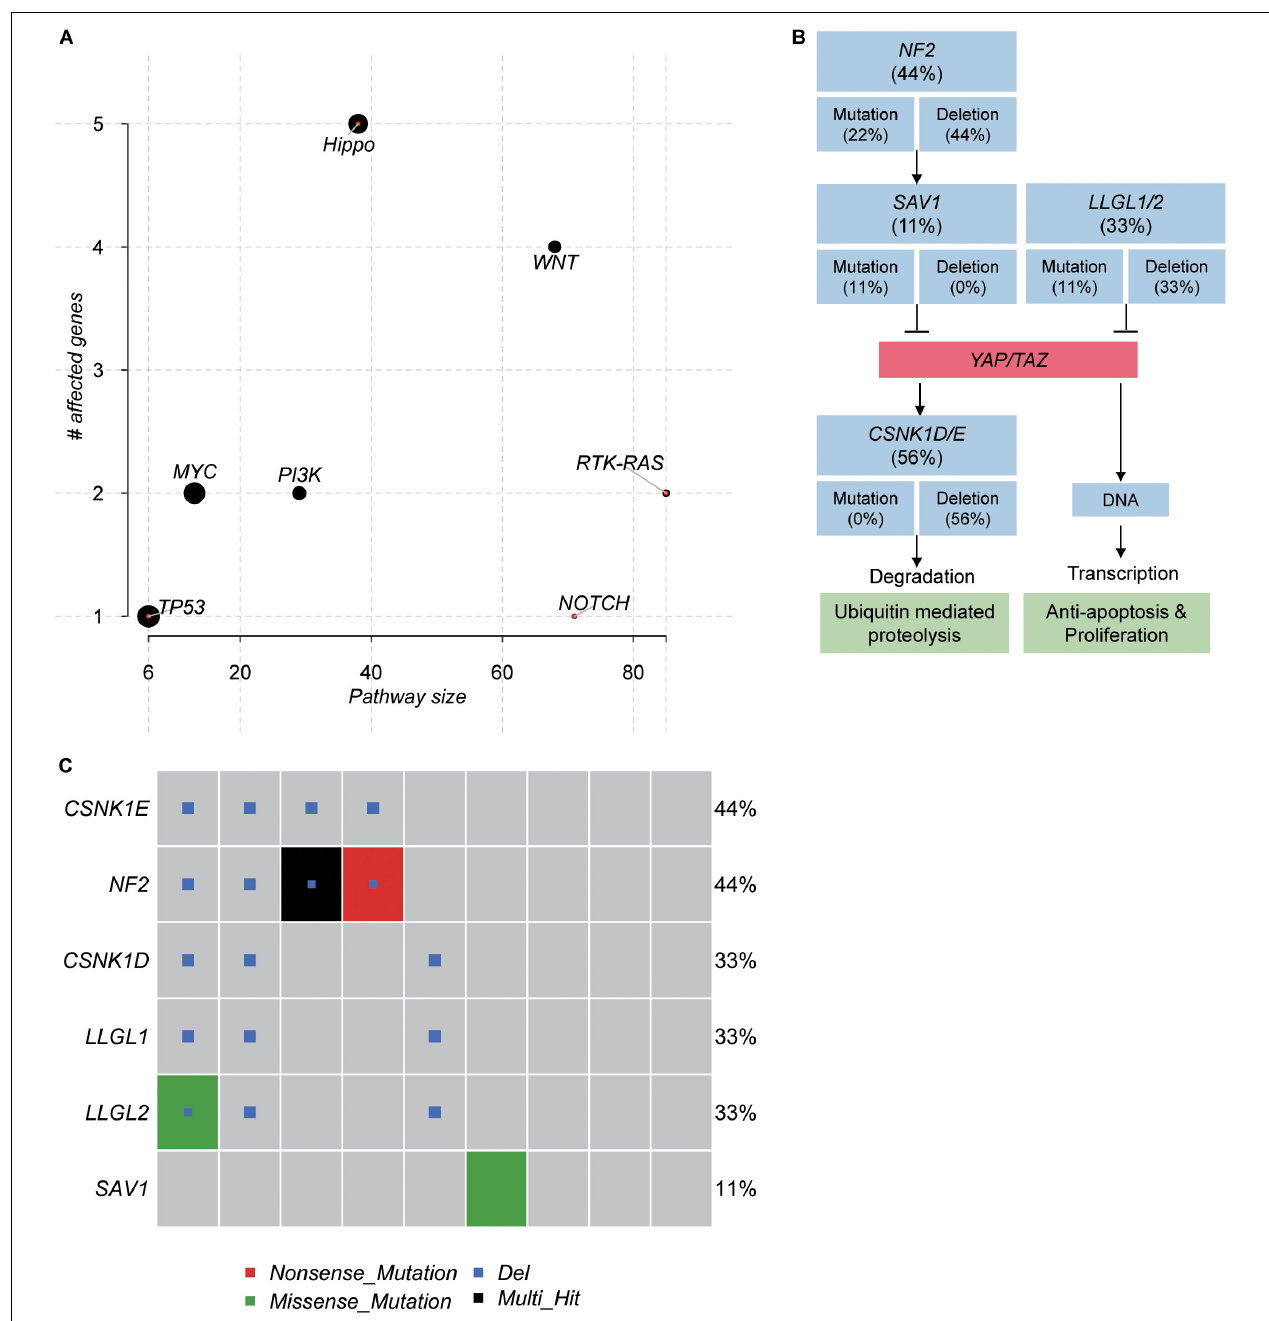
FIGURE 4 | The pathways frequently mutated in spinal schwannoma. (A) The significance of the pathways frequently mutated in spinal schwannoma. The y -axis and x -axis represent the total number of genes and the number of mutated genes in the pathways. (B) The mutated genes and frequency in Hippo signaling pathway. (C) The number of mutated genes in Hippo signaling pathway across the nine spinal schwannomas. The x -axis represents the spinal schwannoma samples. The Multi_Hit indicates multiple variants of a gene were identified in the same sample.